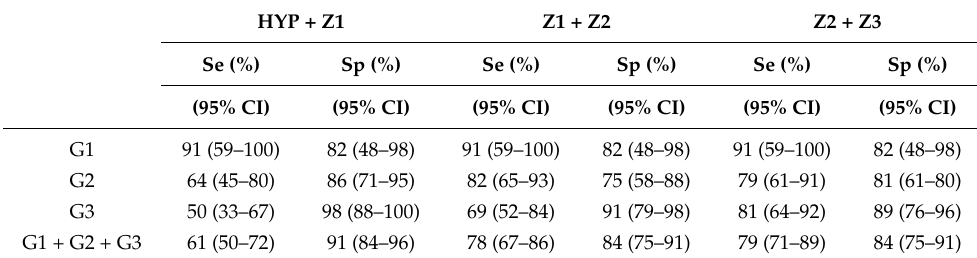
HYP + Z1: sum of scan in HYP and Z1; Z1 + Z2: sum of scan in Z1 and Z2; Z2 + Z3: sum of scan in Z2 and Z3; Se: sensitivity; Sp: specificity; G1: weight ≤ 45 kg; G2: 46 kg ≤ weight ≤ 63 kg; G3: weight ≥ 64 kg; G1 + G2 + G3: total population. The percentages of the true-positive-zones detected with the different US scan win- dows and groups are reported in Figures 2 and 3. Of 138 positive-zones detected through the liver anatomopathological exam, cUS was able to reveal a significantly higher num- ber of positivity (124/138, 90%) when compared to the other scans ( p ≤ 0.01) (Figure 2). Considering the positive-zone detected at the liver anatomopathological exam, the G1 showed a significantly higher percentage (18/20, 90%, 95% CI = 72.0–98.0) of positive-zones than the other groups for HYP scan (G2: 28/54, 52%, 95% CI = 41.0–69.0; G3: 24/64, 38%, 95% CI = 28.5–53.0, G1 + G2 + G3: 74/138, 51%, 95% CI = 46.7–62.2) ( p ≤ 0.01) (Figure 3). Similarly, a significantly higher value ( p ≤ 0.01) was found in G1 when HYP + Z1 was considered (18/20, 90%, 95% CI = 72.0–98.0) (Figure 3). The Z2 resulted positive more times than the others (Z1: 38/124, 30.7%, 95% CI = 20.6–36.0; Z2: 51/124, 41.1%, 95% CI = 29.3–46.1; Z3: 35/124, 28.2%, 95% CI = 18.6–33.9). This observation was also confirmed by anatomopathological exam (Z1: 41/138, 29.7%, 95% CI = 22.2–38.1; Z2: 53/138, 38.4%, 95% CI = 33.7–50.2; Z3: 44/138, 31.9%, 95% CI =